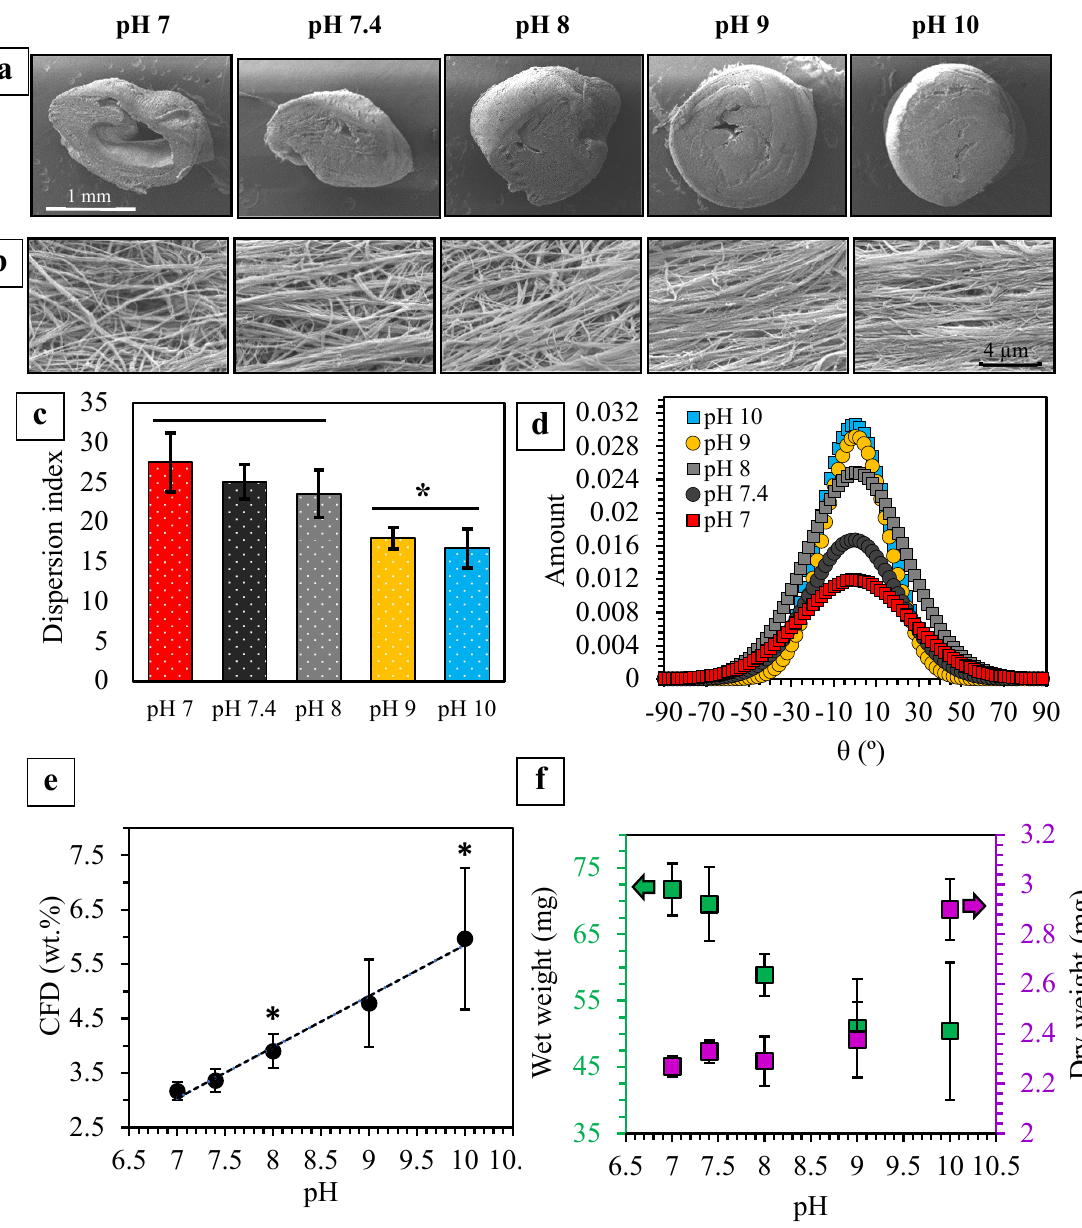
Figure 3. pH-regulated properties of the GAE-densified collagen gels: ( a ) Low magnification cross- sectional and ( b ) higher magnification SEM images of the surface of the GAE-densified gels. ( c ) Colla- gen fibril directionality (* p < 0.05; n = 10) and ( d ) mean collagen fibril dispersion angles of the gels ( n = 10). There was an increase in fibrillar alignment (lower dispersion indices) with an increase in fibrillization pH. ( e ) CFD (* p < 0.05; n = 7) and ( f ) dry and wet weights of the GAE-densified matrices gels as a function of fibrillization